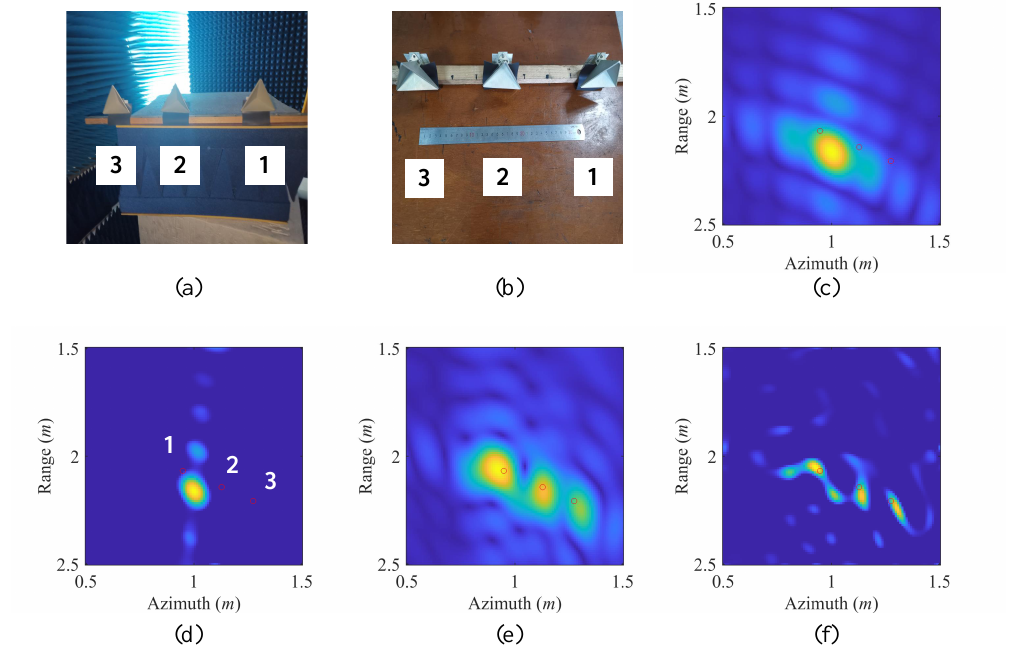
Figure 17. Imaging results of the real-world experiment of SRFS-MSCI. ( a , b ) are the photos of the three reflectors. ( c , d ) are the recovery results from MF and TV regularization method without phase optimization. ( e , f ) are the results from MF and TV regularization method with phase optimization in